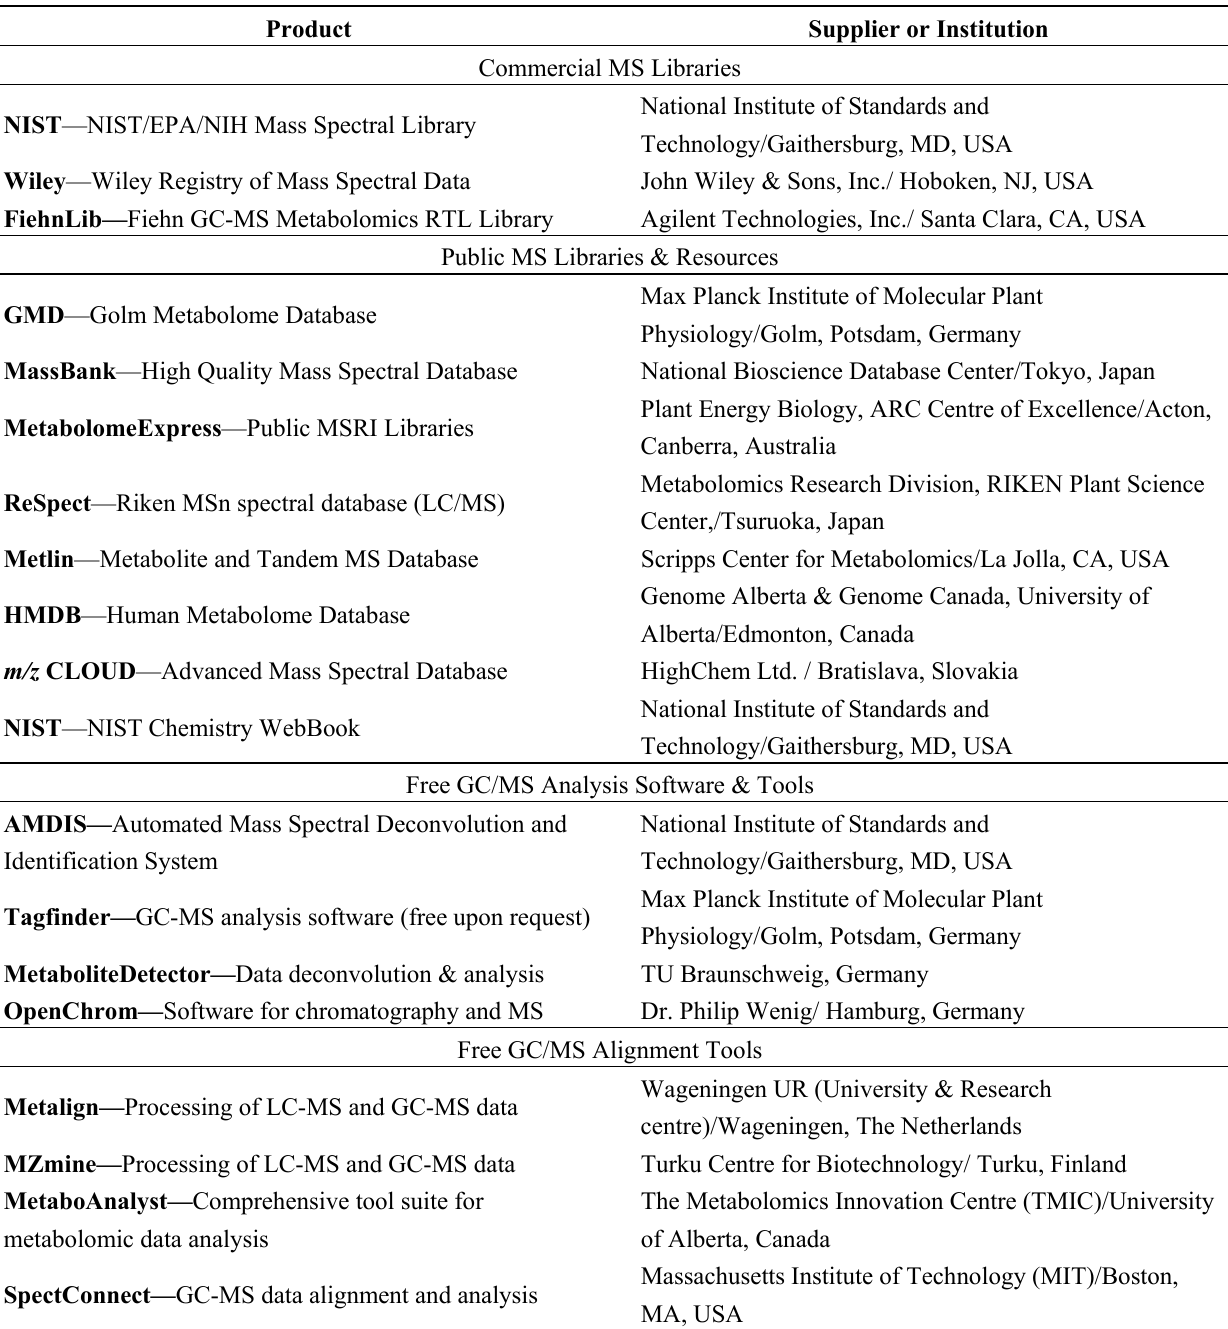
Table 1. Selection of commercially and publicly available MS libraries and resources for structure elucidation and compound identification of GC-MS data. Included is also a list of freely software tools for identification, deconvolution and alignment